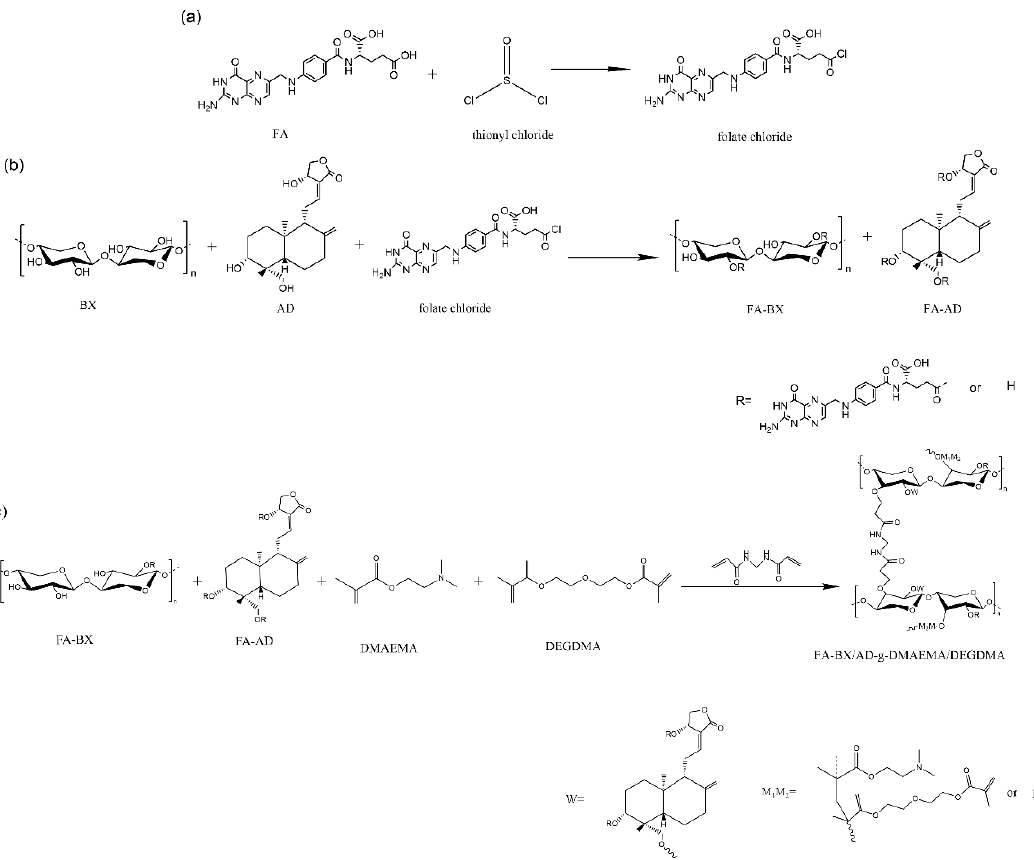
Figure 7. ( a ) Synthesis route of folic acid chloride. ( b ) Synthesis route of FA-BX/AD. ( c ) Synthesis route of FA-BX/AD-g-DMAEMA/DEGDMA.